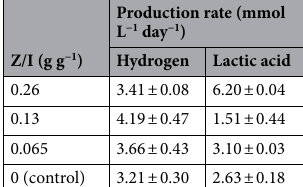
Table 4. Hydrogen and lactic acid production rate (mmol L −1 day −1 ) in batch experiments with Sargassum sp. biomass in the presence and absence of